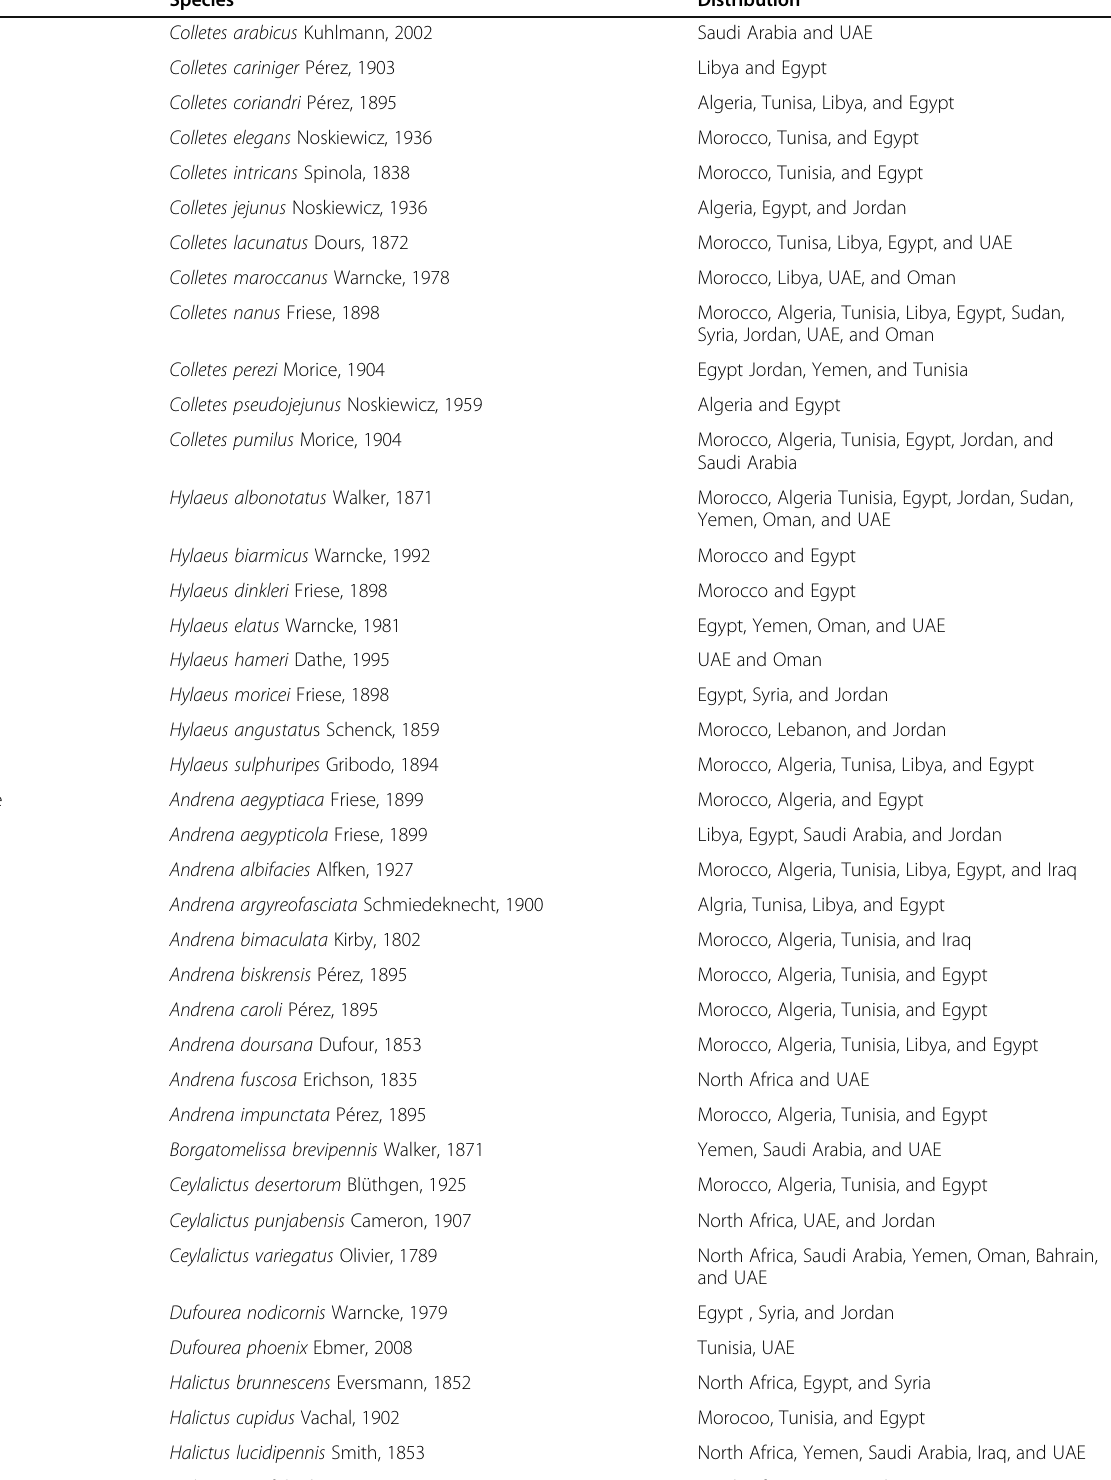
Table 1 List of some common species in North Africa and Middle East (Louadi et al., 2008; Dathe et al., 2009; Grace, 2010; Bendifallah et al., 2010a; Bendifallah et al., 2012; Kuhlmann et al., 2012; Bendifallah et al., 2013; Shebl et al., 2013; Shebl & Farag, 2015; Bendifallah & Ortiz-Sánchez, 2018; Ascher & Pickering, 2020) Family Species Distribution